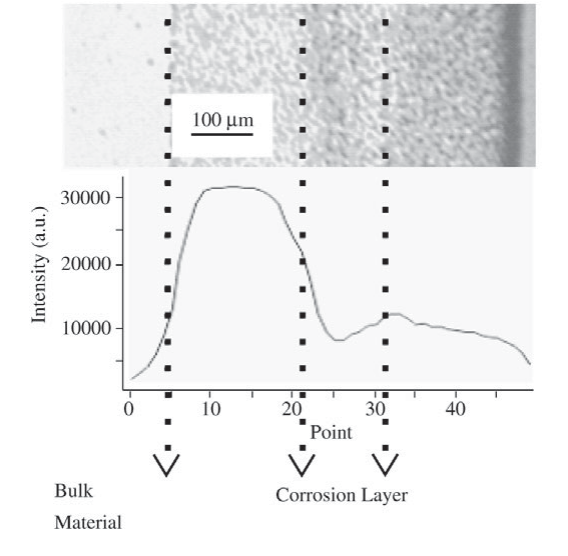
Figure 7. Linescan by Micro Raman Spectroscopy showing rela- tive luminscence intensities of the zones depicted in Fig. 6 from 43